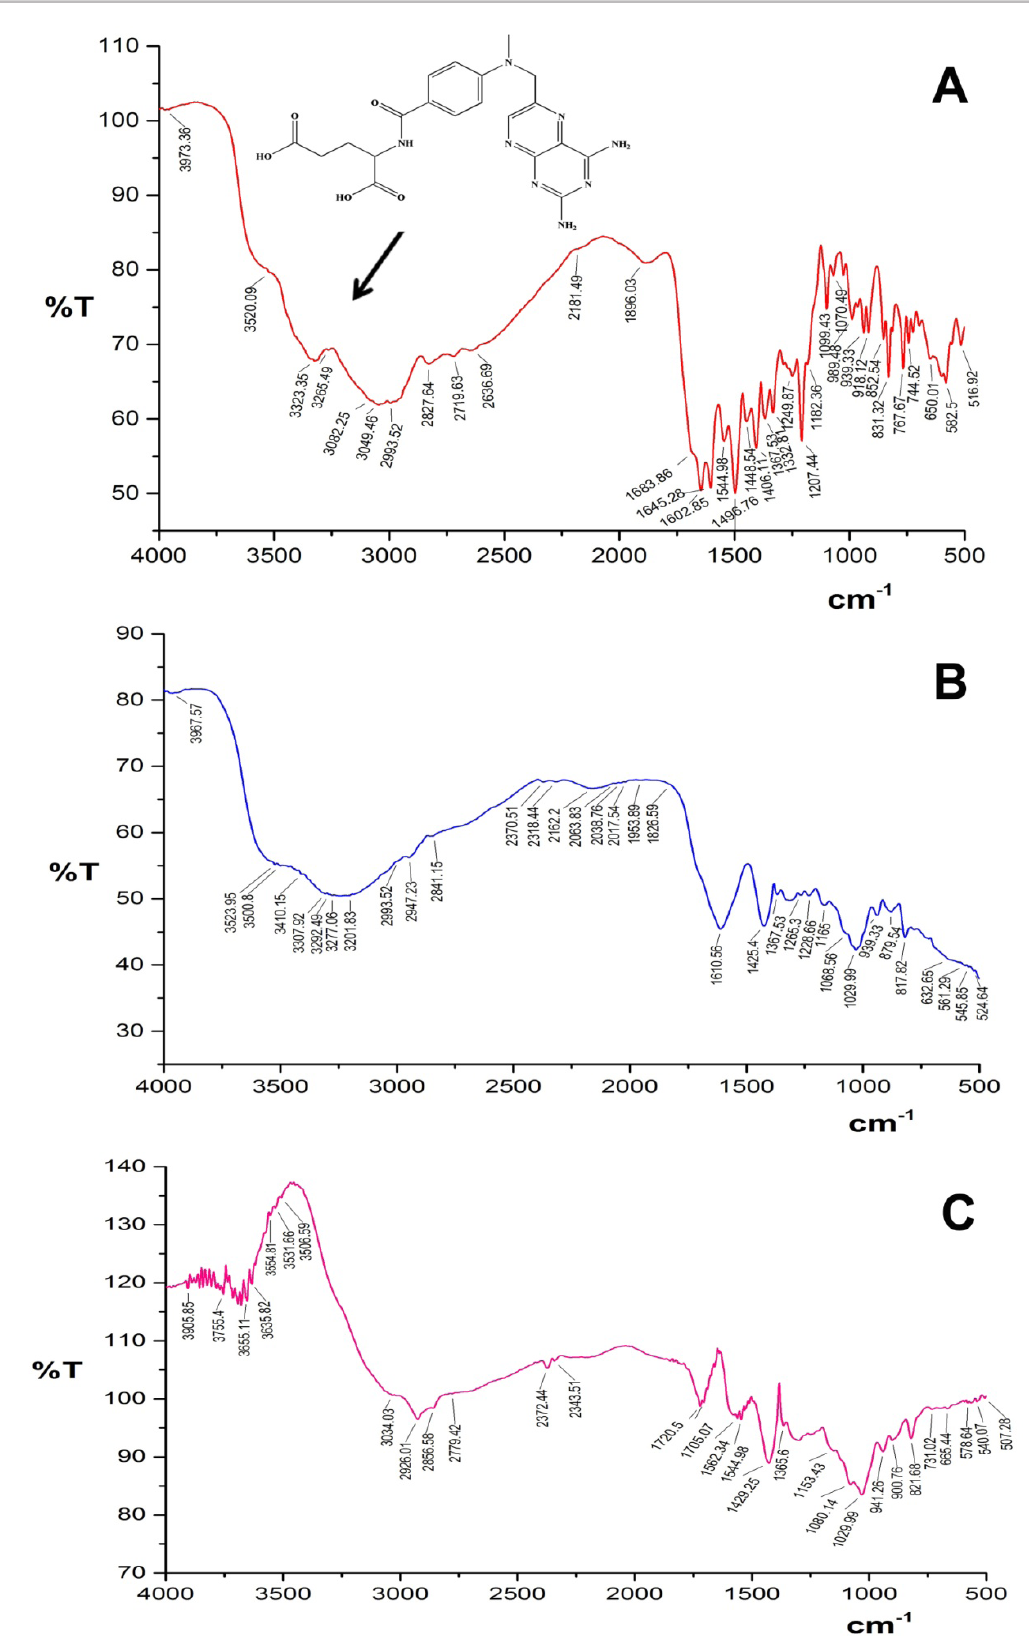
FIGURE 4 – FTIR spectrum of pure methotrexate (A), MTX-MS2 (B) and placebo formulation